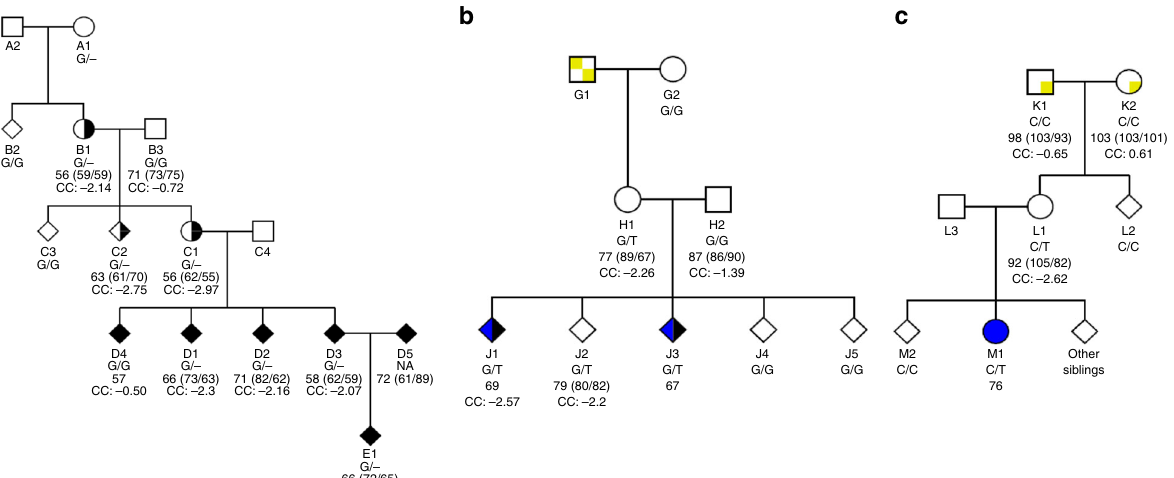
Fig. 1 Pedigree plots for MAP1B LoF carrier families. a Family 1 (FAM1) — E712KfsTer10 (c.2133delG), b Family 2 (FAM2) — E1032Ter (c.3094 G > T) and c Family 3 (FAM3) — R1664Ter (c.4990 C > T). Squares are male, circles are female, diamonds are where gender is withheld, un fi lled are unaffected, fi lled with black are intellectual disability affected, half black and white are individuals without a clinical diagnosis but an IQ below 70, blue are Autism spectrum disorder affected and yellow and white squares within the pedigree symbol indicates where it is most likely the initial MAP1B LoF mutation event occurred. Below each icon is the subjects: alias; MAP1B LoF variant genotype; Full-scale IQ (Verbal IQ/Performance IQ) from WASI IS or WPPSI-R (FAM1-B1,-B3,-C1,- C2,-D1,-D2,-D3; FAM2-H1,-H2,-J2; FAM3-K1,-K2,-L1 or FAM1-D5,-E1, respectively), or only Full-scale IQ reported from WISC-IV (FAM1-D4, FAM2-J1,-J3 and FAM3-M1), and corpus callosum (CC) volume (all individuals with structural MRI also have DTI except FAM1-C1). Refer to Supplementary Figure 2